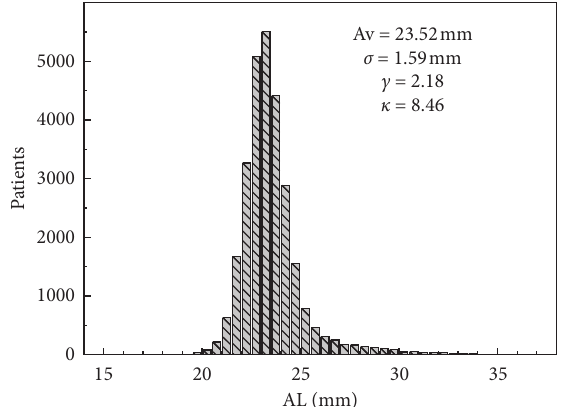
Figure 1: Histogram of the axial length, with 0.5mm bins. In the inset, the main statigraphs of the distribution are shown.